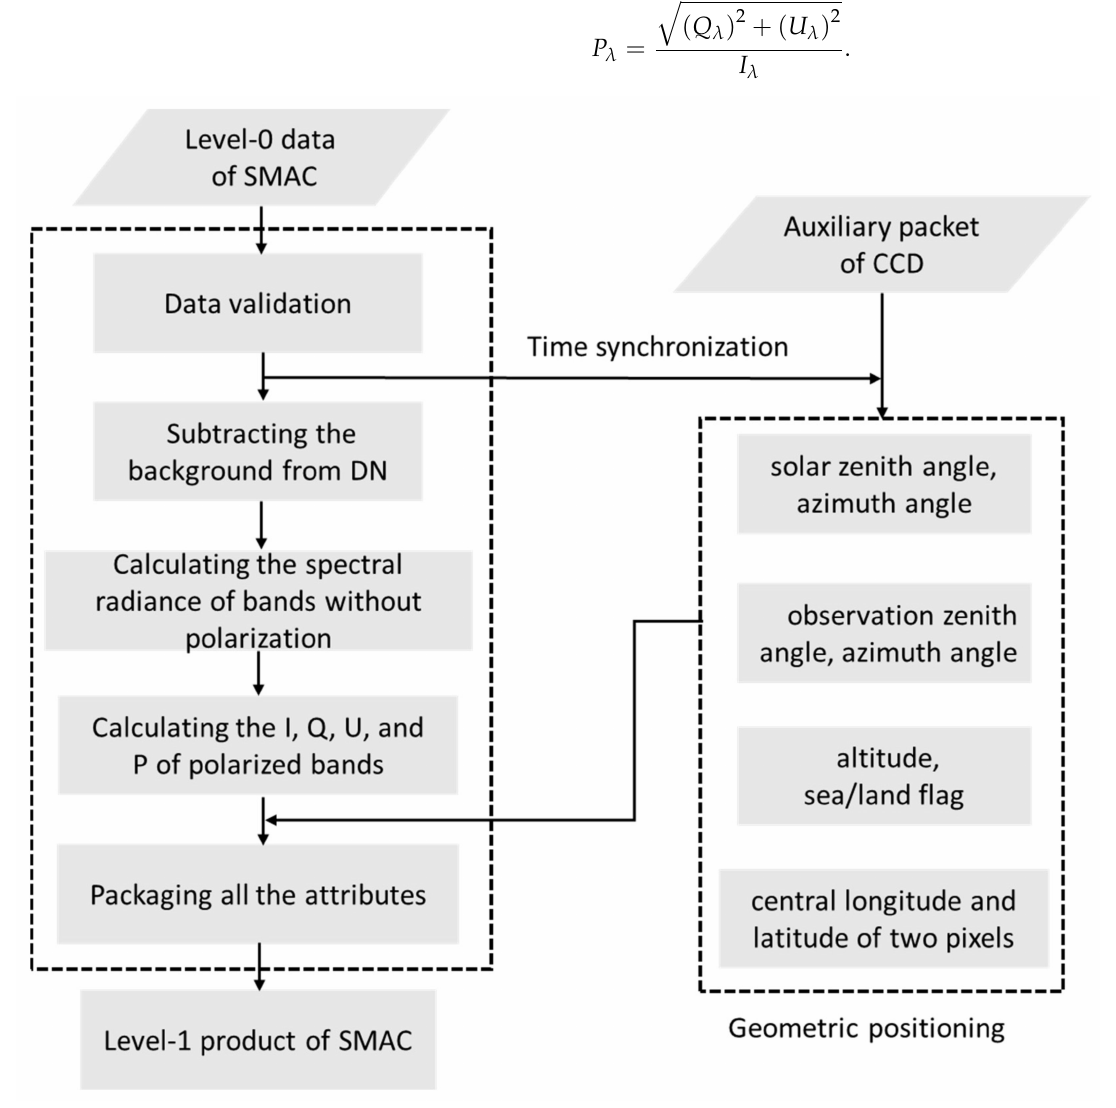
Figure 3. Procedures for processing raw data of